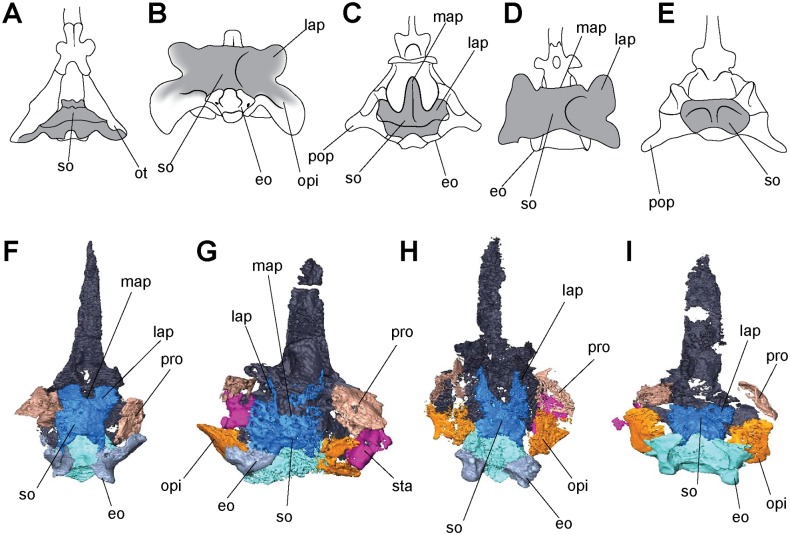
Posterior braincases of selected tetrapods in dorsal view, showing ossifications of the synotic tectum.Interpretive line drawings (A-E) and volumizations (F-I). A, Limnoscelis palustris, after [42]; B, Aerosaurus cf. A. wellesi, after [43]; C, Captorhinus laticeps, after [44]; D, Petrolacosaurus kansensis, after [45]; E, Youngina capensis, after [46]; F, Huskerpeton englehorni (UNSM 32144); G, Rhynchonkos stovalli (FM-UR 1039); H, Aletrimyti (FM-UR 1040); I, Dvellecanus (UCMP 202940). Images not to scale. Abbreviations: eo, exoccipital; lap, lateral ascending process; map, median ascending process; opi, opisthotic; ot, otic; pop, posterior process; pro, prootic; so, supraoccipital; sta, stapes.